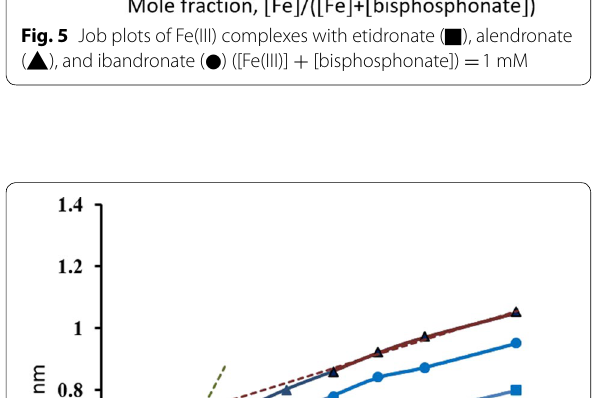
Fig. 5 Job plots of Fe(III) complexes with etidronate ( ■ ), alendronate ( ▲ ), and ibandronate ( ● ) ([Fe(III)]